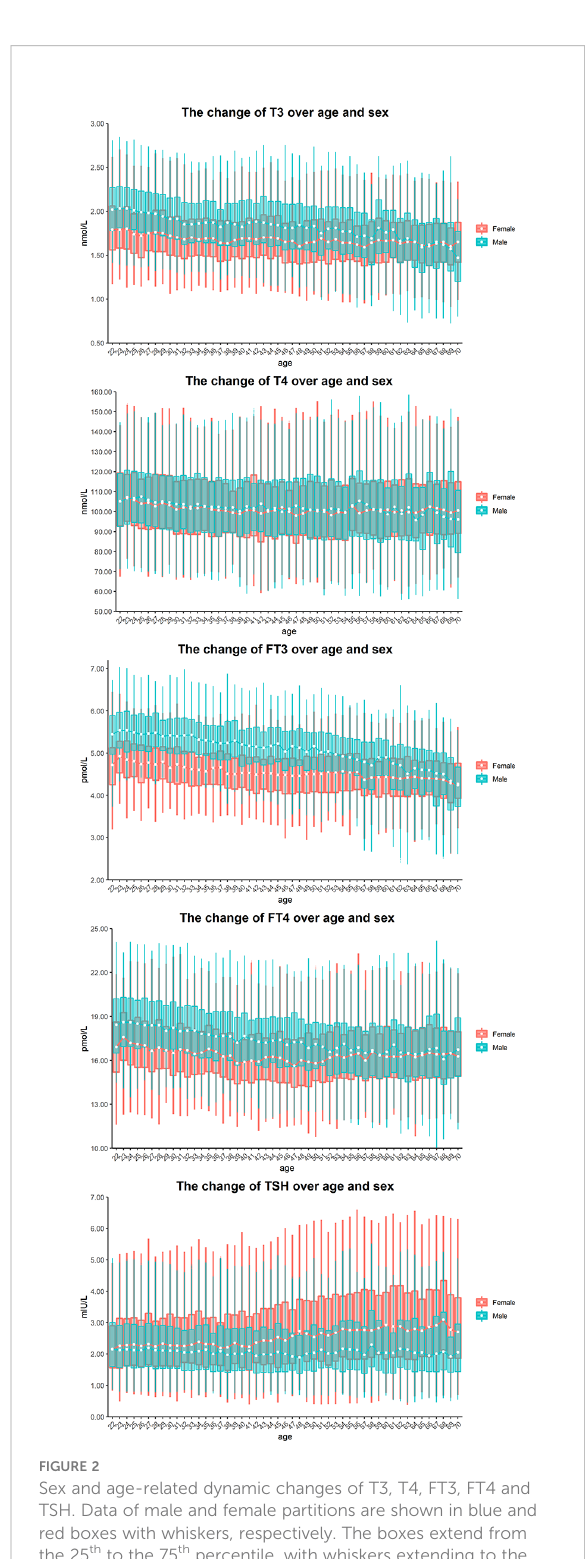
FIGURE 2 Sex and age-related dynamic changes of T3, T4, FT3, FT4 and TSH. Data of male and female partitions are shown in blue and red boxes with whiskers, respectively. The boxes extend from the 25 th to the 75 th percentile, with whiskers extending to the 2.5 th or 97.5 th percentile. Medians are shown as white circles in the body of boxes, and are linked with blue (male) or red (female) line to shown the dynamics. Abbreviations are listed in the legend of Table